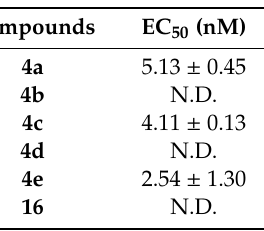
Table 1. EC 50 values of tested